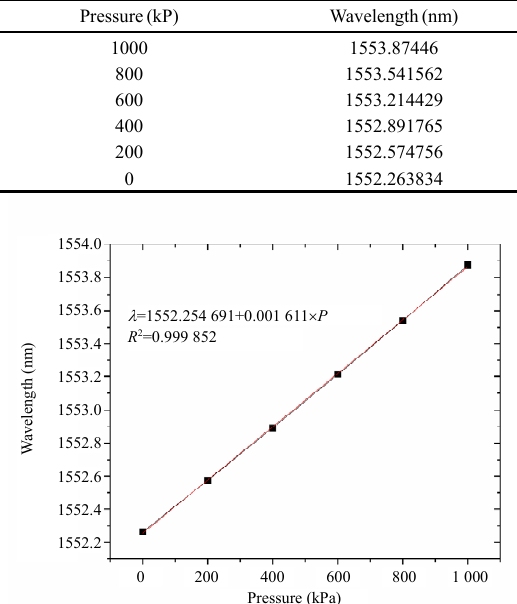
Table 5 FBG pressure sensor pressure calibration data.